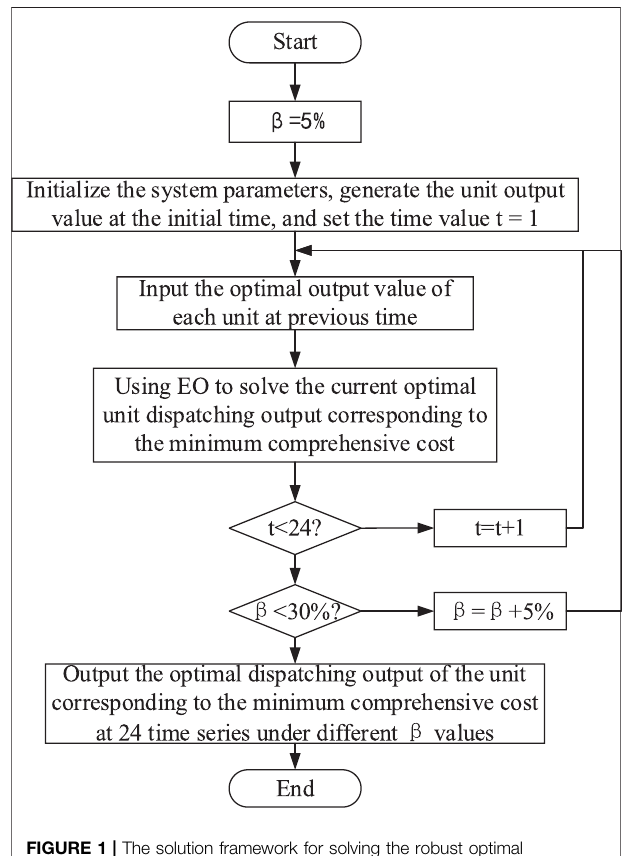
FIGURE 1 | The solution framework for solving the robust optimal dispatching